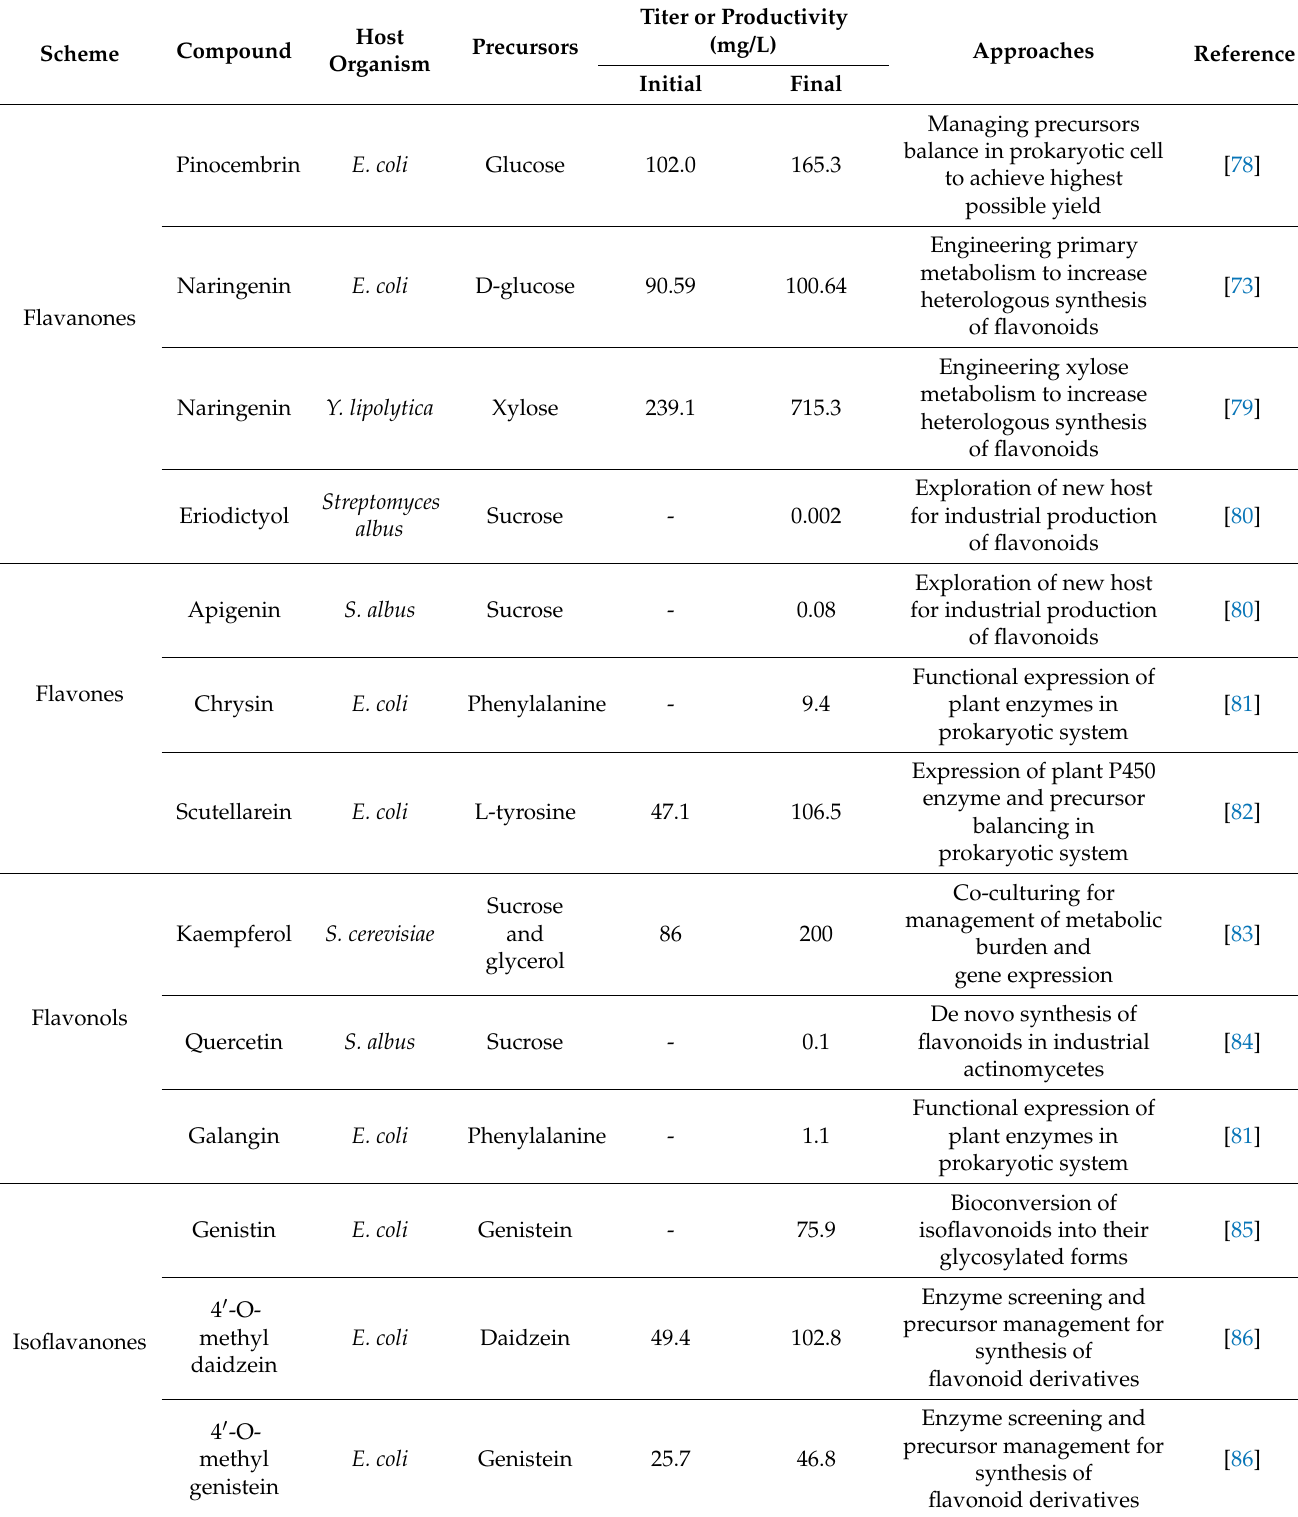
Table 2. Examples of de novo flavonoids biosynthesis in